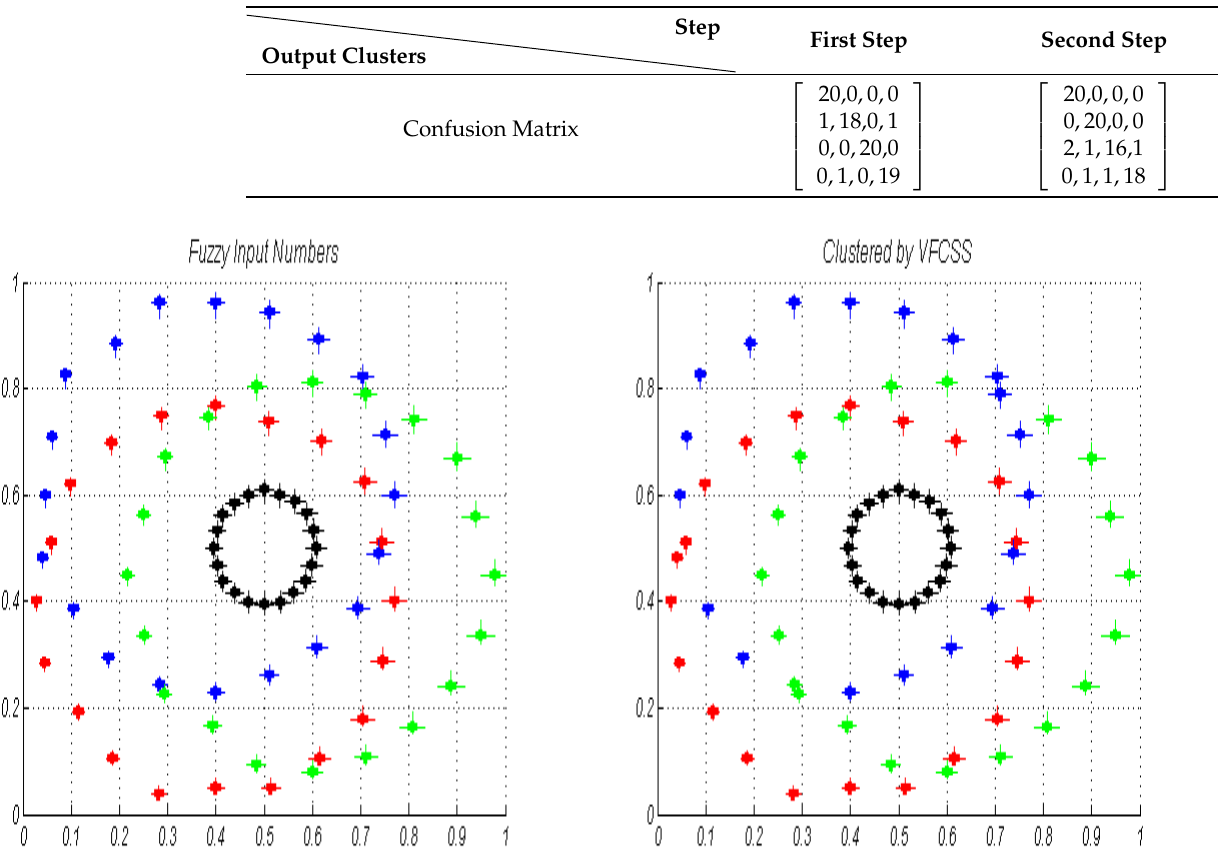
Figure 2. Proposed VFCSS clustering over input LR-type fuzzy numbers include four interference classes red, blue, black and green with (20,20,20,20) members, (first step of state 1).